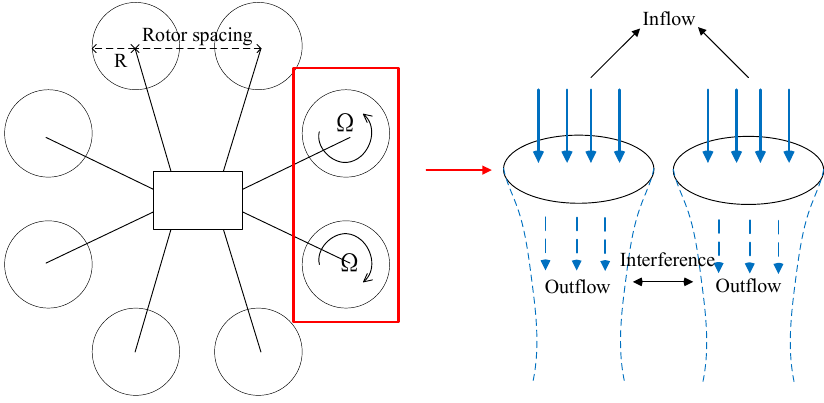
Figure 1. Sketch of the octorotor arrangement.